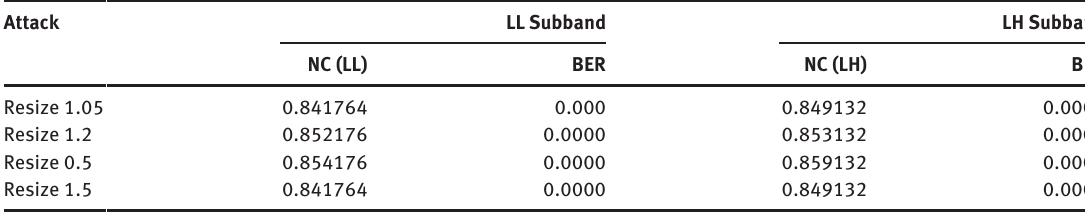
Table 6: Robustness against Resizing Attacks.